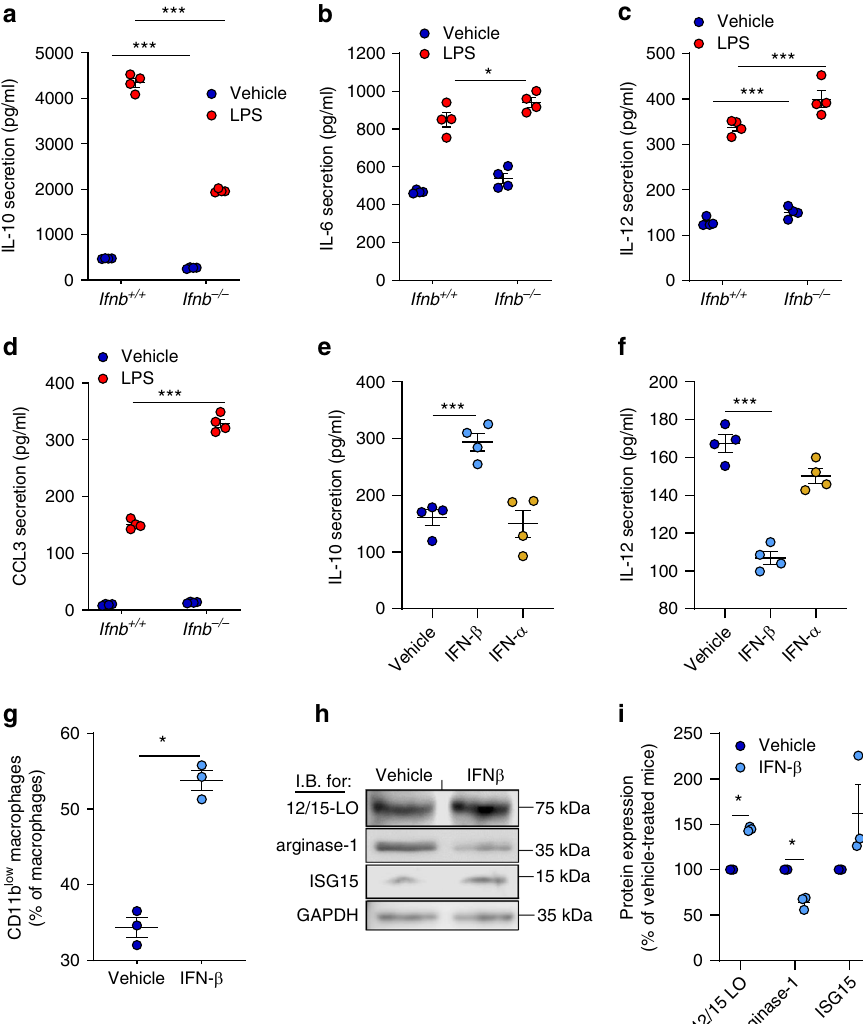
Fig. 7 IFN- β favors macrophage reprogramming during the resolution of in fl ammation. a – d Macrophages were recovered from peritoneal exudates of male Ifnb + / + or Ifnb − / − mice at 48 – 66 h PPI and cultured with LPS (1 μ g/ml) for 24h. Culture supernatants were then collected and levels of IL-10 ( a ), IL-6 ( b ), IL-12 ( c ) and CCL3 ( d ) were determined by selective ELISAs. Results are means± SEM from four independent experiments. * P < 0.05, *** P < 0.005 (Tukey ’ s HSD). e – f Macrophages were recovered from peritoneal exudates of Ifnb + / + mice at 48 – 66 h PPI and cultured with mouse IFN- β or IFN- α (20 ng/ml each) for 48 h. Then, culture supernatants were collected and levels of IL-10 ( e ) and IL-12 ( f ) were determined by ELISA. Results are means ± SEM (n = 4). *** P < 0.005 (Tukey ’ s HSD). g Macrophages were recovered from peritoneal exudates of Ifnb + / + mice 48 – 66 h PPI and incubated with IFN- β (20 ng/ml) for 48 h. The cells were then immunostained for F4/80 and CD11b and the percentage of CD11b low macrophages was determined by fl ow cytometry. Results are means ± SEM from three independent experiments. *** P < 0.005 (Tukey ’ s HSD). h – i Mice undergoing peritonitis were treated with IFN- β (20 ng/mouse, i.p.) or vehicle at 24 h PPI. Peritoneal macrophages were collected at 48 h PPI, lysed and immunoblotted for 12/15-LO, arginase 1, ISG15 and GAPDH. Representative blots ( h ) and densitometry analysis (means ± SEM) ( i ) for three independent experiments. * P < 0.05 (Student ’ s t test). Source data are provided as a Source Data fi